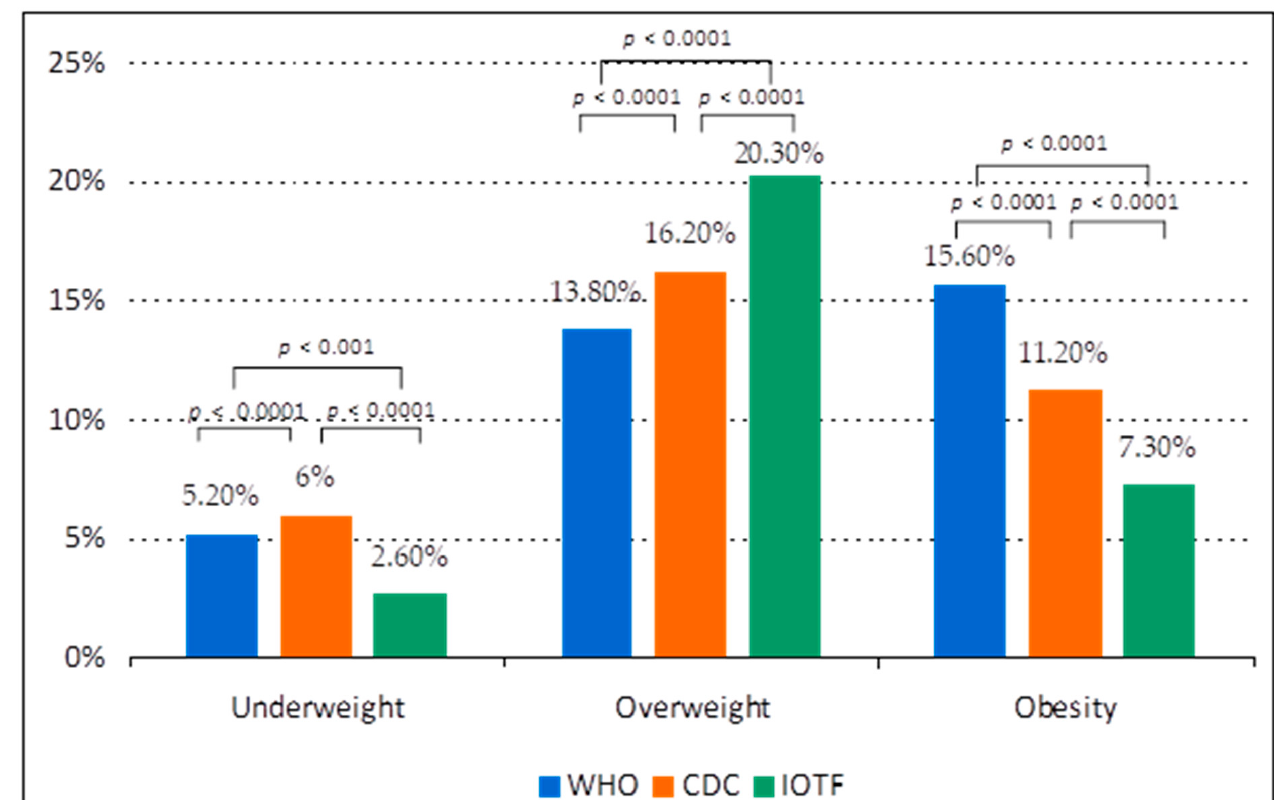
Figure 1. Prevalence of underweight, overweight and obesity in children aged 7–18 years using the WHO, CDC and IOTF references.